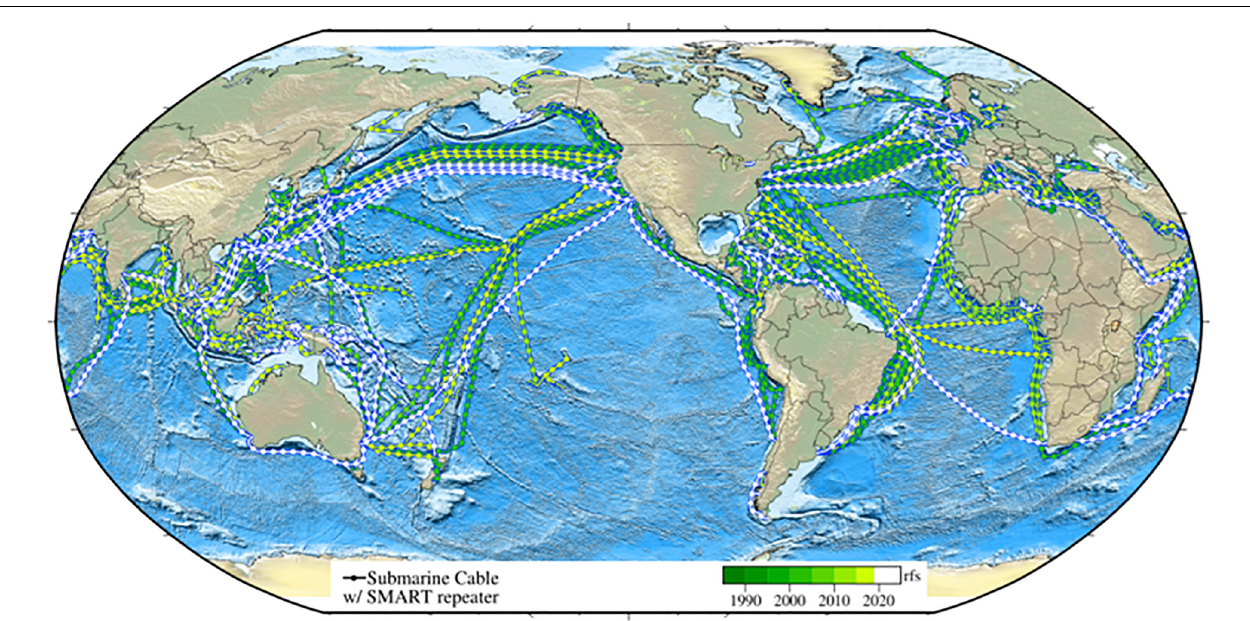
FIGURE 1 | Current and planned cables span the oceans, enabling the Internet and our society. As they are replaced and expanded over their 10–25 year refresh cycle, environmental sensors (pressure, temperature, acceleration) can be added to the cable repeaters every ∼ 100 km, gradually obtaining real time global coverage (for clarity, repeaters are shown only every 300 km. rfs – year ready for service). Cable data: TeleGeography’s Telecom Resources licensed under Creative Commons ShareAlike. Permission obtained for use of